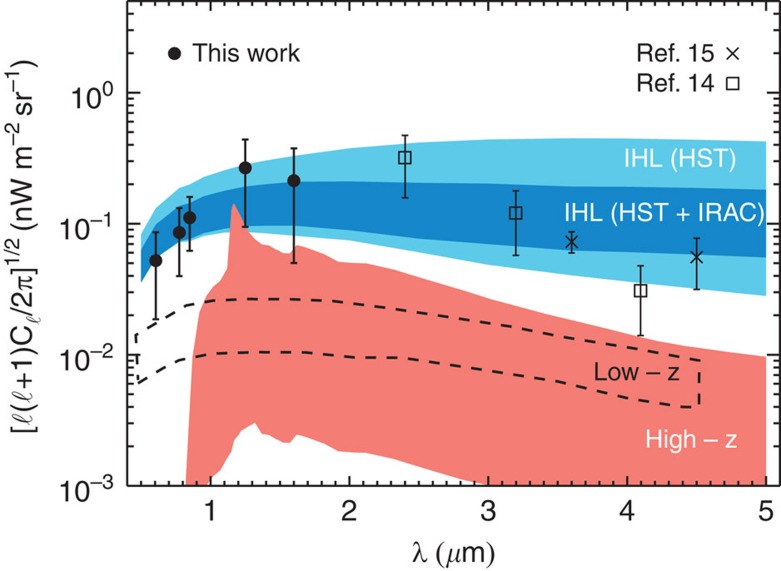
Spectral energy distribution of optical and infrared fluctuations at arcmin angular scale.The Hubble/CANDELS points are averaged over 104≤ℓ≤3 × 104, with the best-fit shot noise and DGL components subtracted. Our model fits for the high-redshift and IHL components, with their 1σ bounds, are shown as the filled regions. The errors here are propagated from the errors on the auto spectrum at the same ℓ range. The light blue region shows the 1σ confidence bound for the IHL component when we use only the HST data in our model fitting; the dark blue region shows the 1σ confidence bound for the IHL component when use both the HST and Spitzer IRAC data in our model fitting. The light red coloured region signifies the 1σ error bound for the high-redshift model component. The dashed line corresponds to the 1σ bound for the low-redshift component. The Spitzer15 and AKARI14 data are taken from previous measurements at ℓ=3,000. Note the spectral dependence difference between the high-redshift signal and IHL. Below 0.8 μm we do not expect any signal from z>8 galaxies. The presence of fluctuations at optical wavelengths requires a low-redshift signal in addition to high-redshift sources to explain combined optical and infrared background intensity fluctuations.